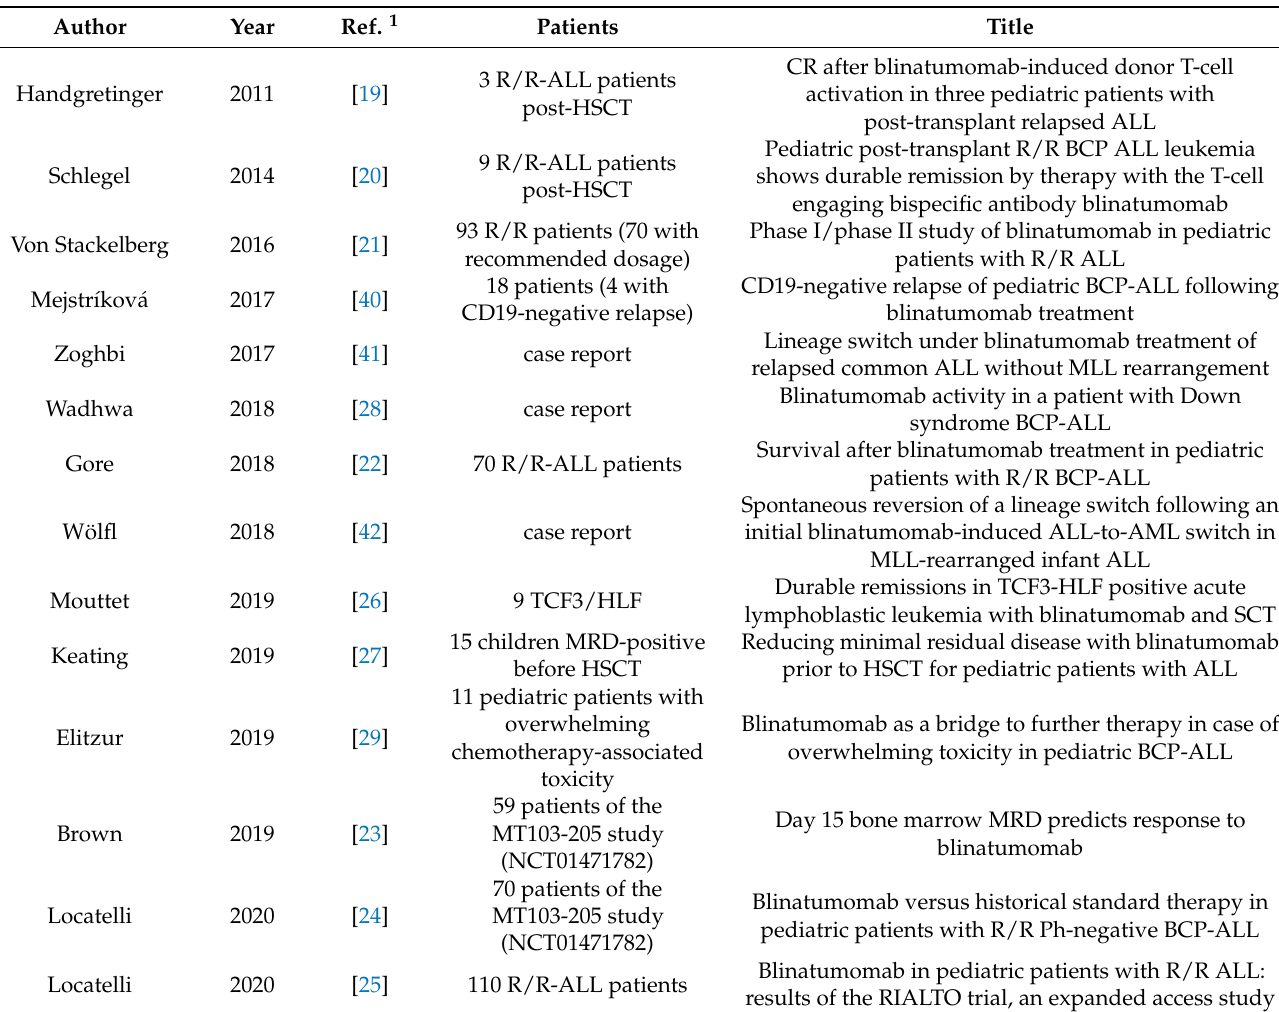
Table 1. Table with all articles published on use of blinatumomab in pediatric